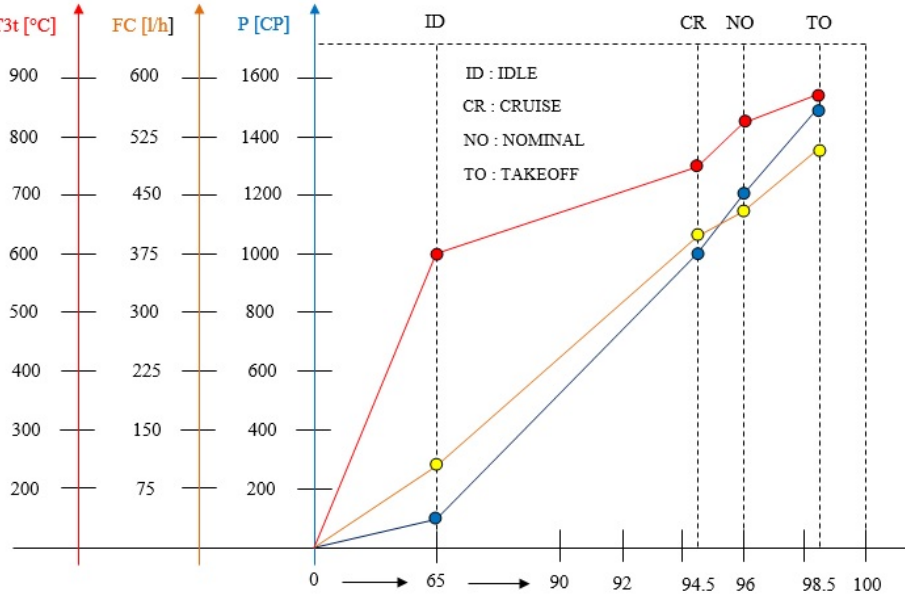
Figure 1. Main engine parameters chart TV2-117A (AG).